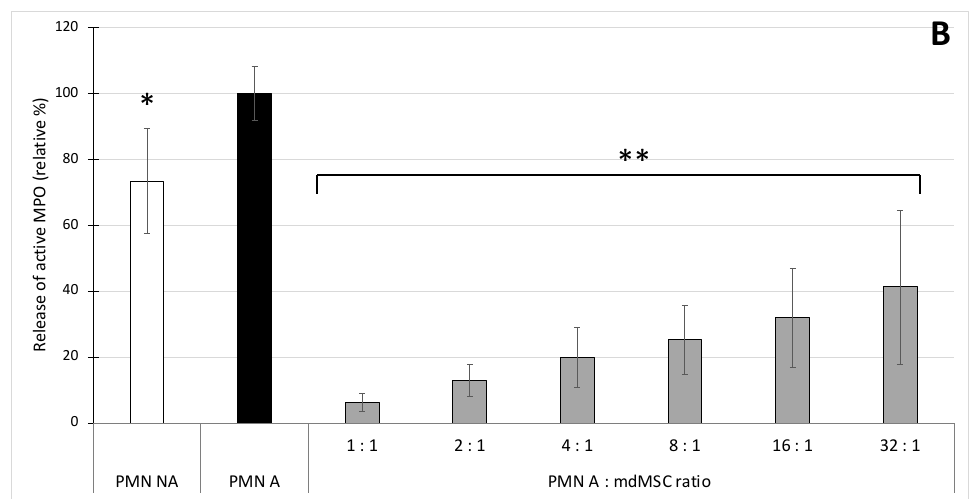
Figure 2. Effect of non-activated (PMN NA) and CB/fMLP-activated neutrophils (PMN A) alone or mixed with mdMSCs at different ratios (PMN A:mdMSC ratio) in DPBS on the degranulation of total ( A ) and active MPO ( B ). Results from five independent experiments ( n = 5) with 2 technical replicates for each point, including 4 horses for mdMSCs, 5 horses for neutrophils. Means ± SD are shown in relative percentages versus stimulated neutrophils alone defined as 100% response (PMN A). Statistical analysis was considered for 5 independent experiments ** p < 0.01, * p < 0.05 vs. PMN A.